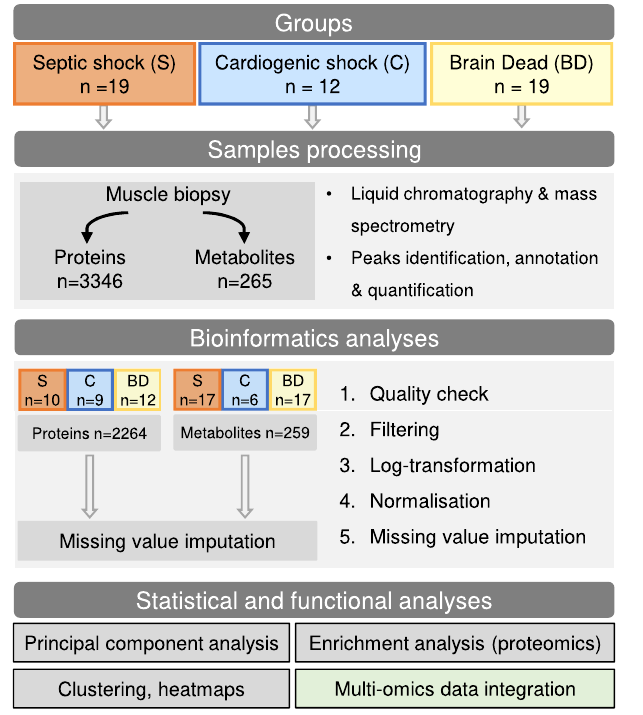
Figure 1. Study design and general overview.